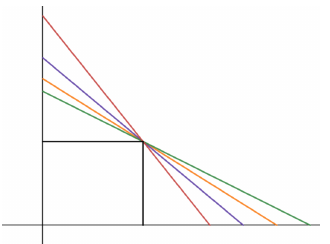
Figure 4. An example of four feasible curves when r =